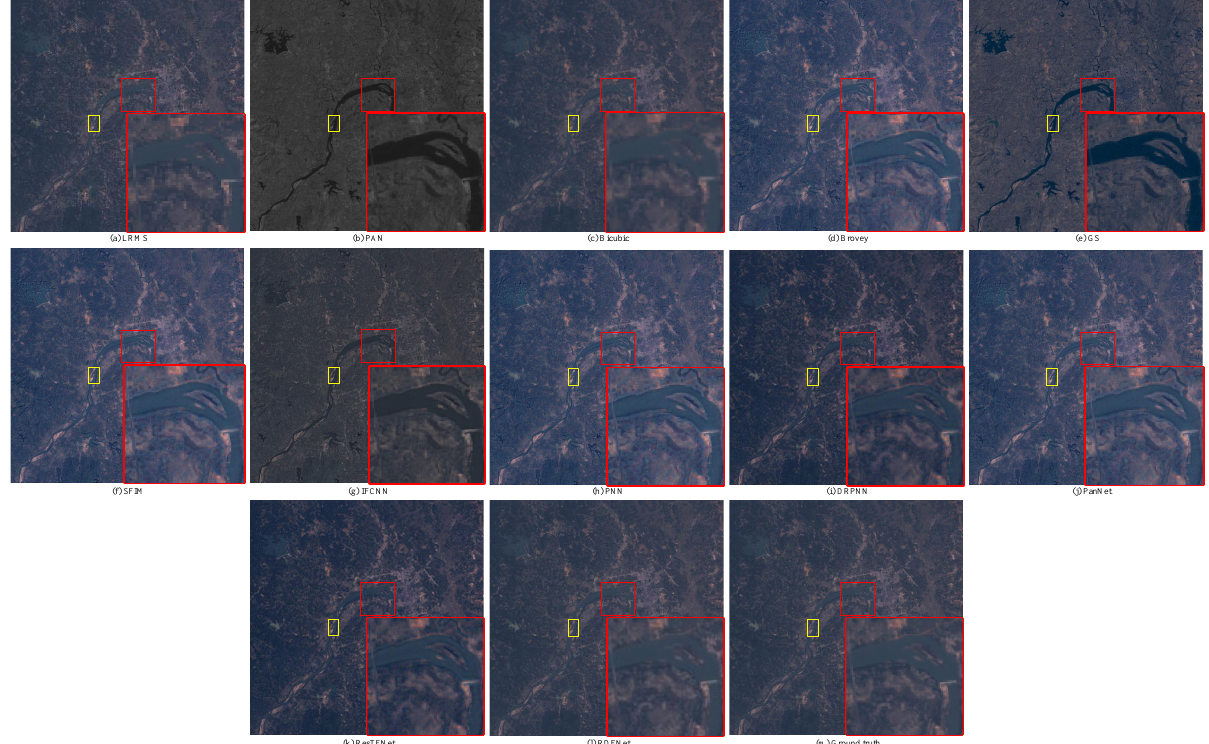
Figure 18. Subjective comparison between RDFNet and the current mainstream fusion methods for testing dataset fusion results of Landsat-7 with reduced resolution. ( a ) LRMS; ( b ) PAN; ( c ) Bicubic; ( d ) Brovey; ( e ) GS; ( f ) SFIM; ( g ) IFCNN; ( h ) PNN; ( i ) DRPNN; ( j ) PanNet; ( k ) ResTFNet; ( l ) RDFNet (ours); ( m ) ground